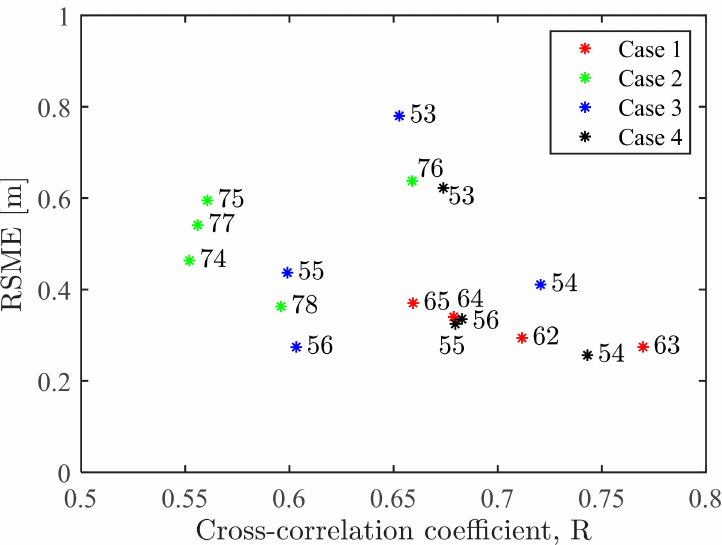
Figure 14. Relationship between RMSE and the mean cross-correlation coefficient for different